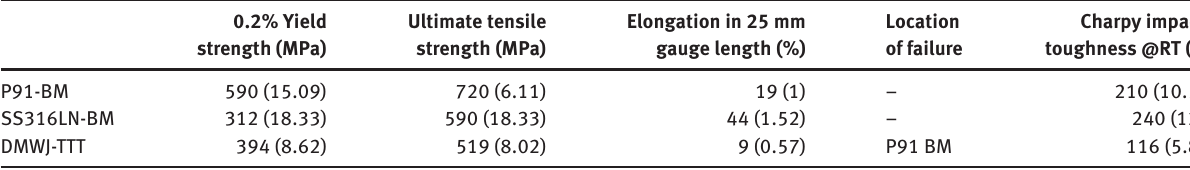
Table 4: Tensile and impact toughness properties of base metals and